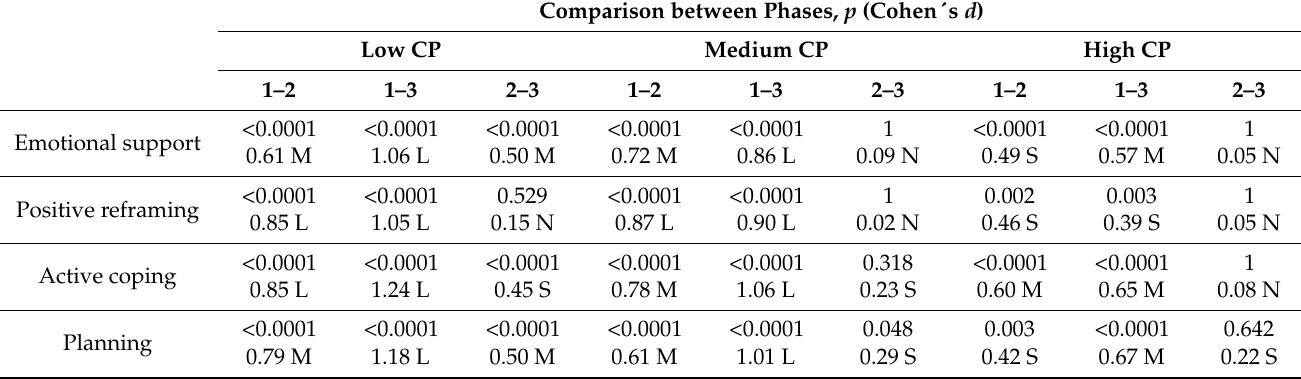
Table note: L = large effect size, M = medium effect size, S = small effect size, N = null effect